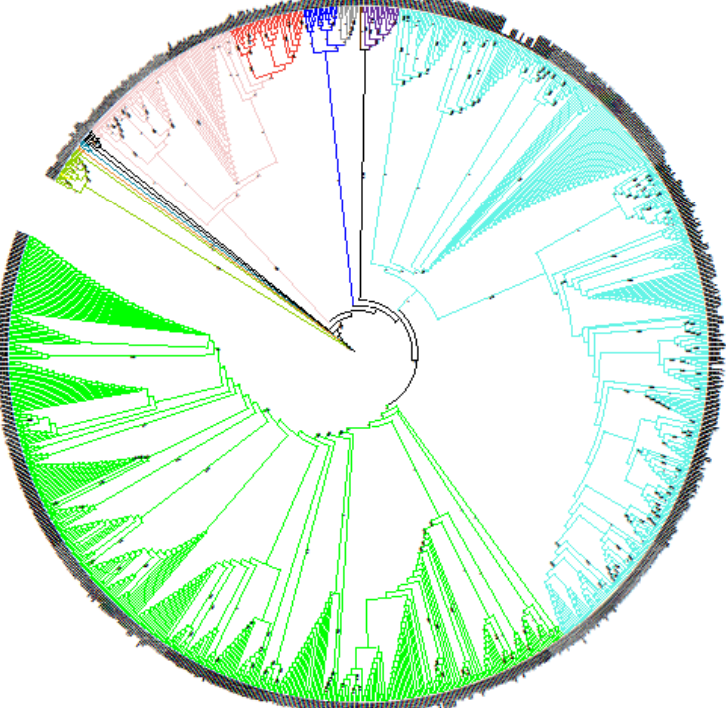
Figure 1. Global phylogeny of Brucella genus. Evolutionary history was inferred by using Maximum Likelihood method and Kimura 2-parameter model. Initial tree(s) for heuristic search was obtained automatically by applying Maximum Parsimony method. Tree is not drawn to scale (branch lengths does not correspond to number of substitutions per site). This analysis involved 988 genome se- quences. There was a total of 12,730 positions in final dataset. Evolutionary analyses were conducted in MEGA X. All species are color-coded: green for B. abortus , light blue for B. melitensis , grey for B. pinnipedialis , dark blue for B. ceti , purple for B. ovis , brown for B. papionis , red for B. canis , pink for B. suis , black for B. neotomae , light green for B. sp, dark green for B. microti , yellow for B. inopinata and orange for B. vulpis . Bootstrap values are indicated at branch nodes (between 0 and 1).